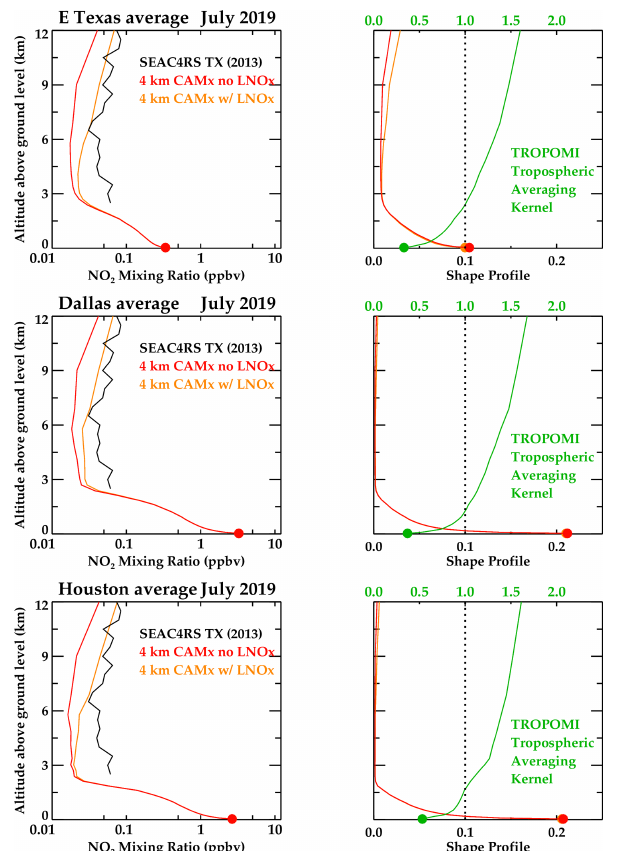
Figure 3. The left panels show the NO 2 vertical concentration profiles between the surface and 12km altitude from the CAMx model with (orange) and without (red) lightning NO x emissions for July 2019 and the median free tropospheric NO 2 in situ ob- servations acquired during the August–September 2013 NASA SEAC4RS field campaign (black) for (top panels) the eastern Texas average, (middle panels) Dallas, and (bottom panels) Houston. Or- ange and red dots represent surface concentrations. The right pan- els show the NO 2 shape profiles – the fraction of the column at any given altitude – from the same two model simulations and the TROPOMI tropospheric averaging kernel for the same locations. The dotted line indicates an averaging kernel of